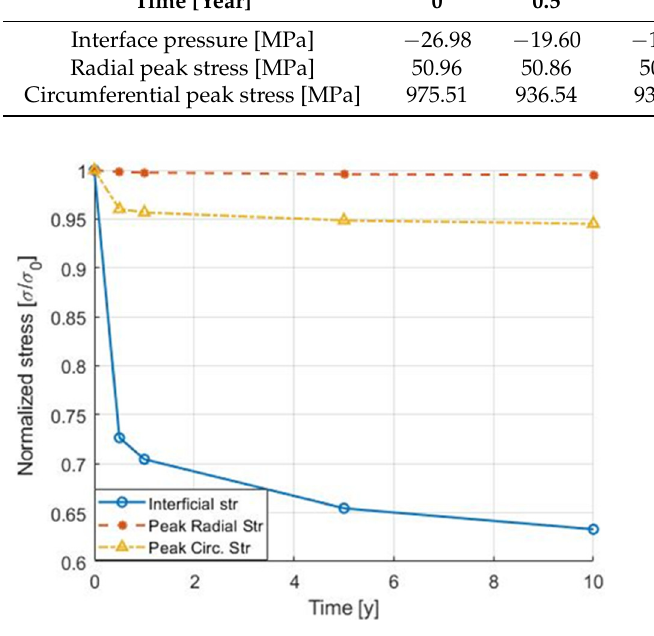
Table 4. Rotor peak stress values for interfacial stress, radial peak stress, and circumferential peak stress at 0, 0.5, 1, 5, and 10 years of continuous flywheel operation at limit velocity. Time [Year]